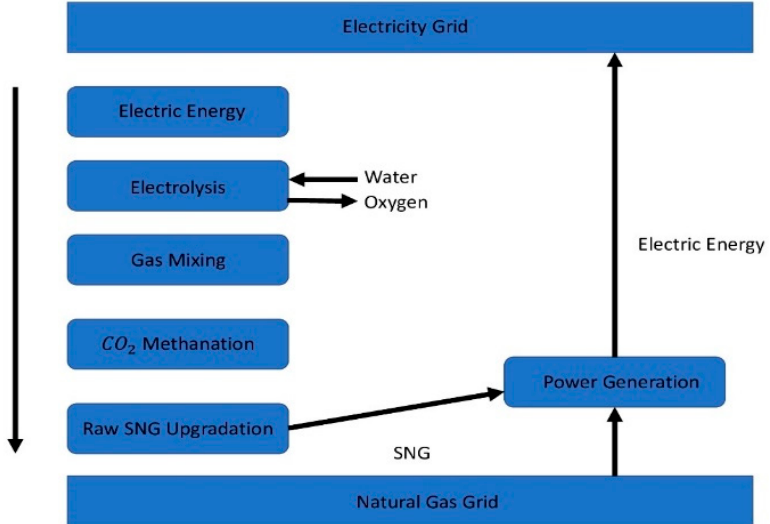
Figure 8. Representation of the CO 2 methanation process and reactions.